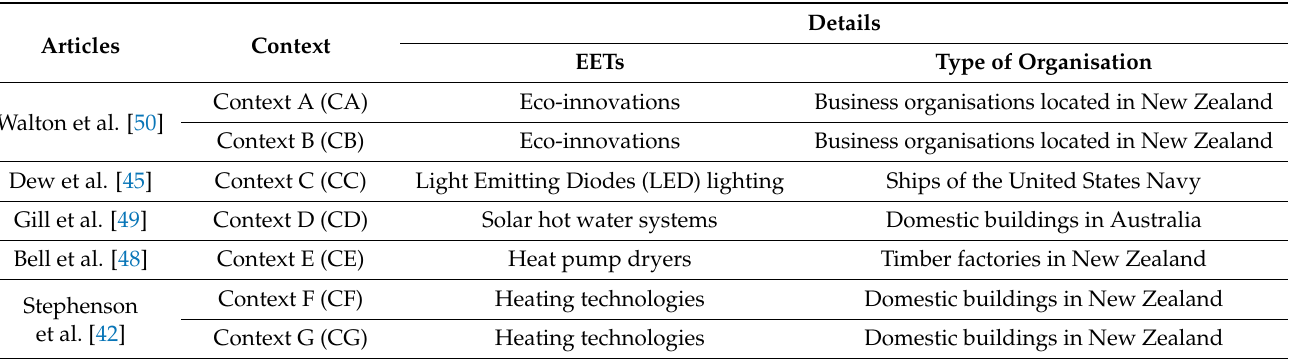
Table 4. Summary of the selected